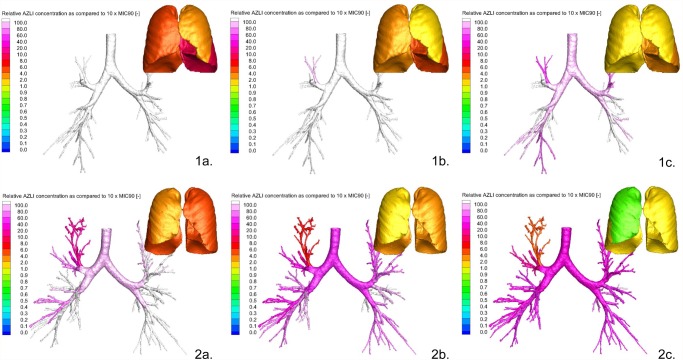
Relative AZLI concentrations in central and small airways of 2 patients for 3 different scenarios.Simulations of AZLI deposition in 2 patients, representing 3 scenarios of varied airway surface liquid thickness (ASL) and aerosol diameter. Severity of CF lung disease was determined by the CF-CT score (% of total CF-CT score). Scenario a = thin ASL with smallest aerosol diameter; scenario b = median ASL with median aerosol diameter; scenario c = thick ASL with largest aerosol diameter. Part 1a, 1b and 1c: Patient 1, mild CF lung disease: bronchiectasis 0.0%, airway wall thickening 0.0% and air trapping 11.1%. Patient 1 received concentrations > 10xMIC90 in the central and small airways independent of ASL thickness and aerosol diameter (Part 1a, 1b, 1c). Part 2a, 2c and 2c: Patient 2, more severe lung disease: bronchiectasis 12.5%, airway wall thickening 11.1% and air trapping 38.9%. Patient 2 received concentrations > 10xMIC90 in the central and small airways in scenario a and b (Part 2a and 2b), but AZLI concentrations < 10xMIC90 in the small airways in scenario c (right upper and middle lobes) (Part 2c).